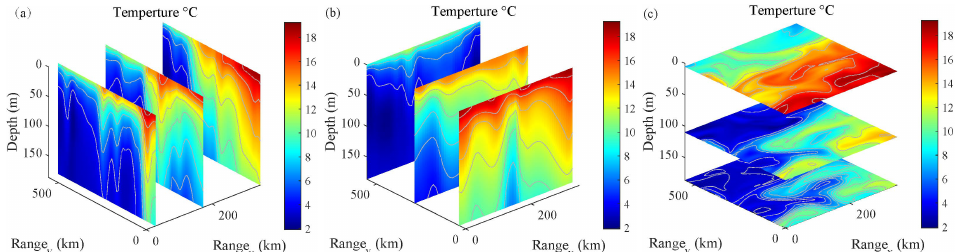
Figure 12. Three-dimensional temperature structure of the front transect. ( a – c ) are slices of the temperature in the yz plane, xz plane and xy plane, respectively